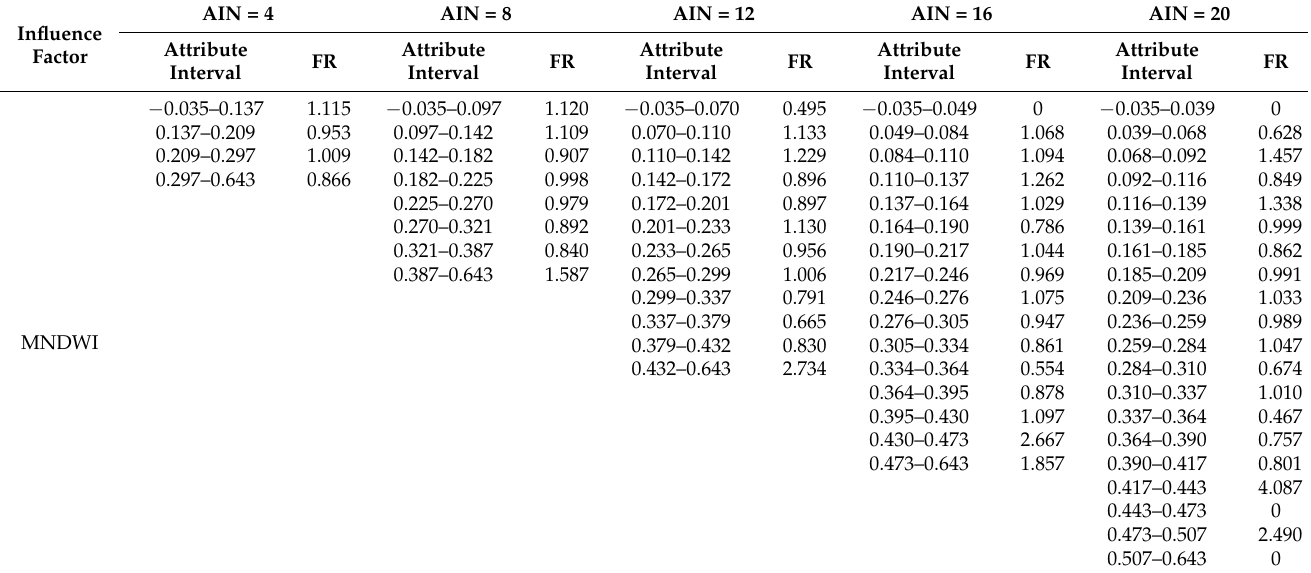
Table 3. Frequency ratio of hydrologic factors.